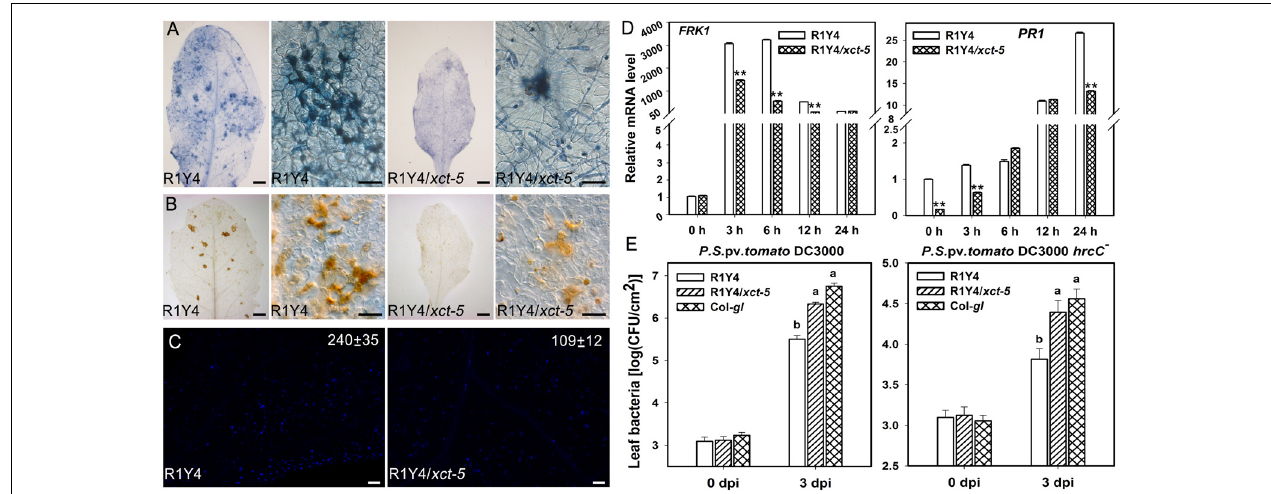
FIGURE 3 | Mutation in XCT compromises RPW8.1 -mediated immunity. (A,B) Representative infected leaves and leaf sections show fungus-induced cell death (A) and H 2 O 2 production (B) in the indicated lines at 8 days post inoculation (dpi) of powdery mildew. Scale bars, 50 µ m. (C) Flg22-induced callose deposition in the indicated lines. Leaves from 5-week-old plants were injected with 2 µ M of flg22 and samples were stained with 0.01% aniline blue at 12 h post injection. Scale bars, 10 µ m. Image J was used for quantification of callose deposition. The average number of callose deposits ( ± SE) from four different leaves is indicated in the images. Similar pictures were captured from more than three infected lines and similar results were obtained in two independent experiments (A–C) . (D) Quantitative RT-PCR analysis on the expression of the indicated defense-related marker genes in R1Y4/ xct-5 and R1Y4 at 0, 3, 6, 12, 24 h after treated by flg22. Transcript levels were normalized to that in R1Y4 at 0 h. Error bars indicate SD ( n = 3). Asterisks ∗∗ above the bars indicate significant difference between b3-17 and R1Y4 ( t -test, P < 0.01). (E) Bacterial growth assay on the indicated plants. Fully expanded leaves of the indicated plants were injected with the virulent strain Pseudomonas syringe DC3000 and the non-pathogenic mutant strain P. syringae DC3000 ( hrcC - ). Bacterial growth was scored at 0 days post inoculation (dpi) and 3 dpi, respectively. Error bars indicate SD ( n = 6). Letters above the bars indicate significant differences ( P < 0.01). Similar results were obtained in three independent